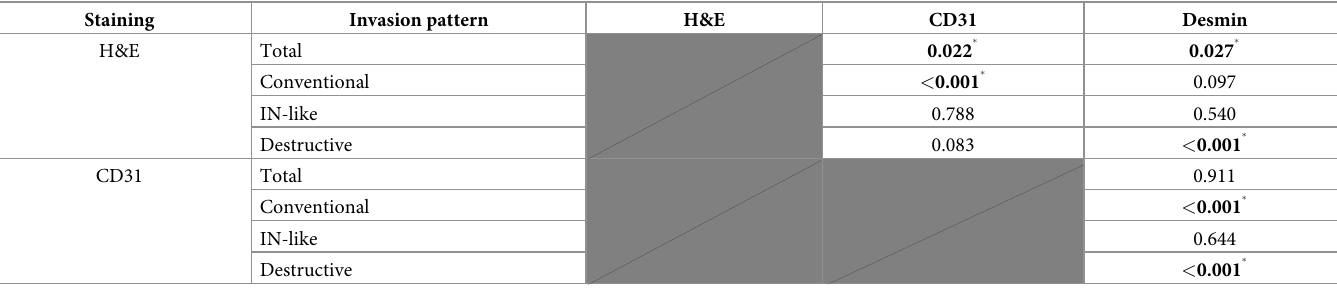
Table 3. Comparisons of vascular invasion patterns based on staining methods in the test set.